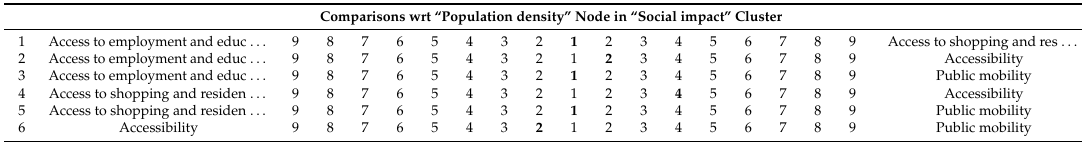
Table 3. Comparisons between population density and social